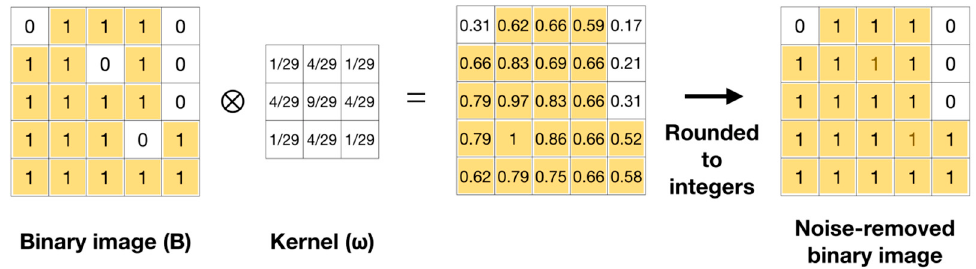
Figure 2. Convolution operation for noise reduction. A binary image (B) is smoothed by the Gaussian kernel ( ω ). The binary image contains two pixels of 0s (open cells) that are surrounded by 1s (shaded cells) and considered noise. The convolution operation generates a matrix with the two noise cells filled by values above the Gaussian threshold (0.5). The transformed binary image displays the removed noise.